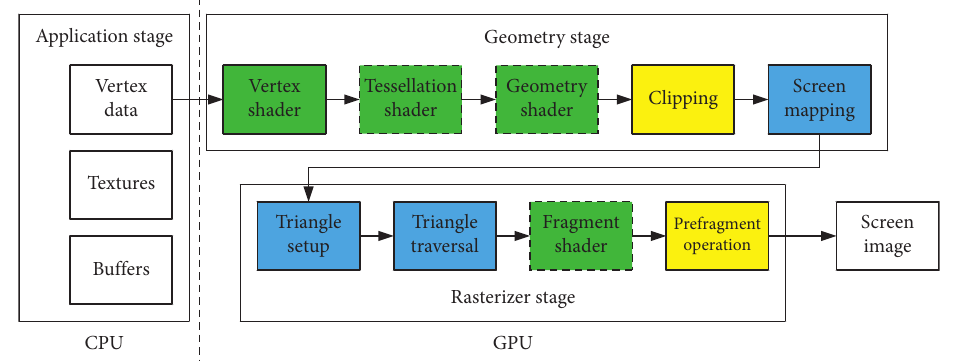
Figure 1: Implementation for graphic